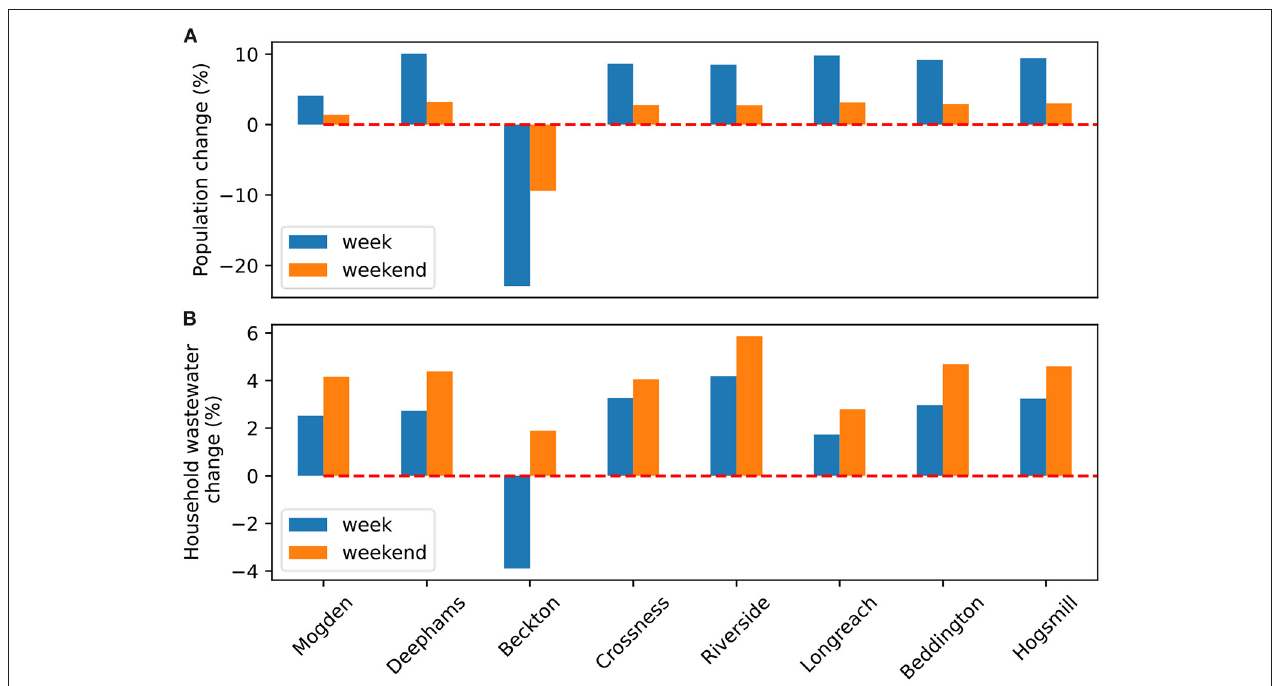
FIGURE 8 | Population change during lockdown (A) and household wastewater flow change (B) on weekdays and weekends. Changes are the relative difference between the baseline scenario and lockdown scenario. Zero change is marked by the dashed red line.